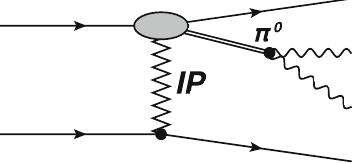
Fig. 5 The π 0 -strahlungprocessdiagram.The blob indicatesamixture of different mechanisms of the pion emission